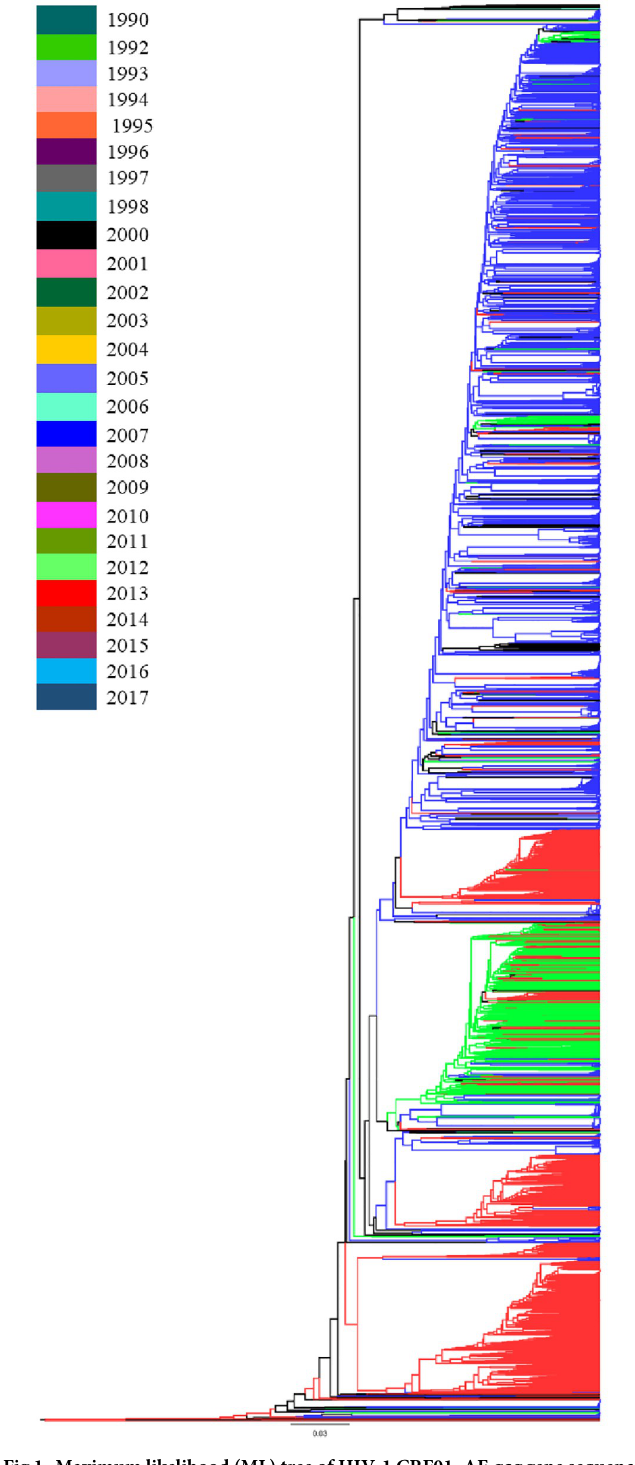
Fig 1. Maximum likelihood (ML) tree of HIV-1 CRF01_AE gag gene sequences. ML tree was used to infer the phylogenetic relationship among the 3105 HIV-1 CRF01_AE gag sequences submitted to the LANL HIV Sequence Database, representing the years 1990 to 2017. The tree was color-coded based on the years groups. The color key for the tree is given within the figure.